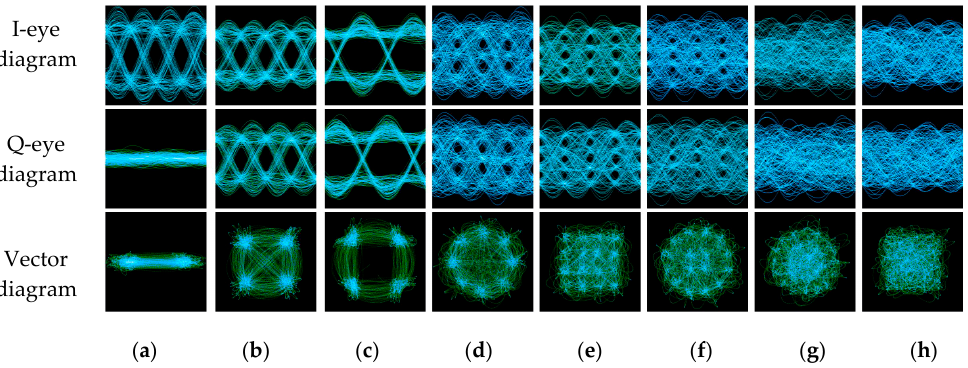
Figure 2. The eye diagram and vector diagram of different modulation signals in 15dB ( a ) BPSK; ( b ) QPSK; ( c ) OQPSK; ( d ) 8PSK; ( e ) 16QAM; ( f ) 16APSK; ( g ) 32APSK; ( h ) 64QAM.